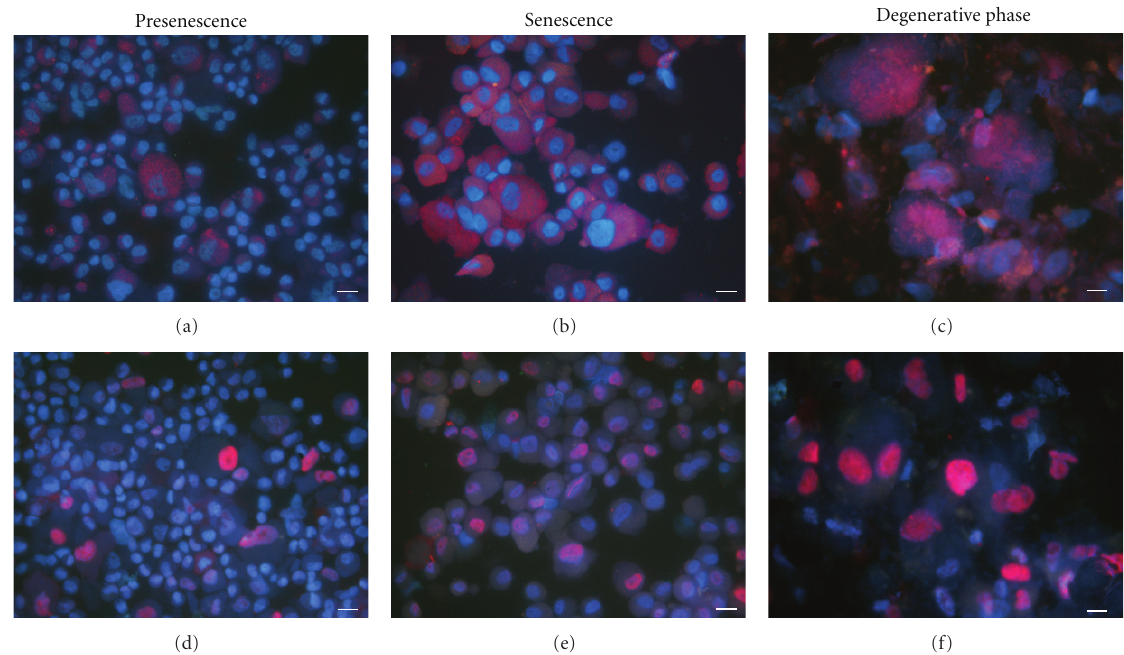
Figure 1: Phenotypic characteristics of IMR90 in the process of senescing showing cell enlargement and the accumulation of principal growth inhibitors involved in the regulation of senescence, p16 and p21, in three stages: ((a), (d)) presenescence, ((b), (e)) senescence, ((c), (f)) degeneration phase. ((a)–(c)) p16 (red) and DAPI (blue); ((d)–(f)) p21(red) and DAPI (blue). Scale bar = 20 μ